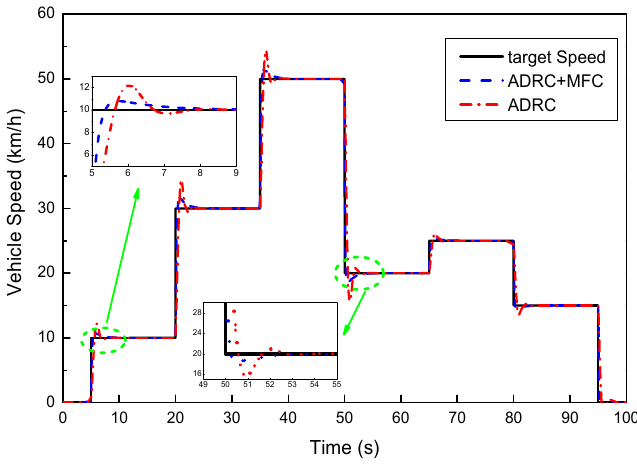
Figure 4. Speed tracking results for Case 1.